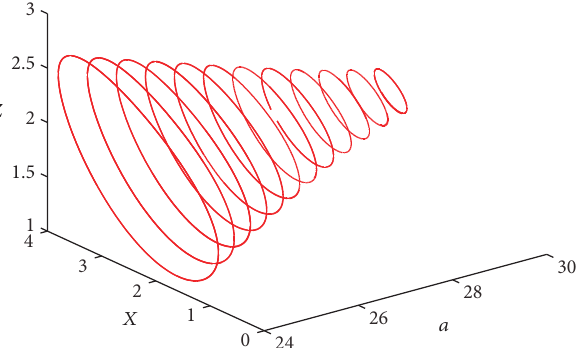
Figure 6: The evolution of the limit cycles with the parameter 𝑎 in the neighborhood of Hopf bifurcation. Initial conditions: (1,1,1,1) . Parameters: {𝑏 = 2 , 𝑐 = 3 , and 𝑑 = 10} .